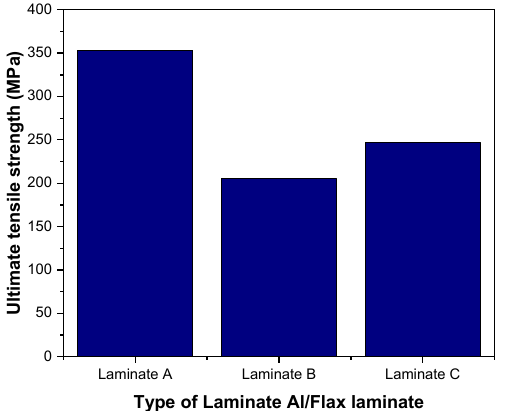
Figure 5. Comparison of ultimate tensile strength of the three laminate configurations.